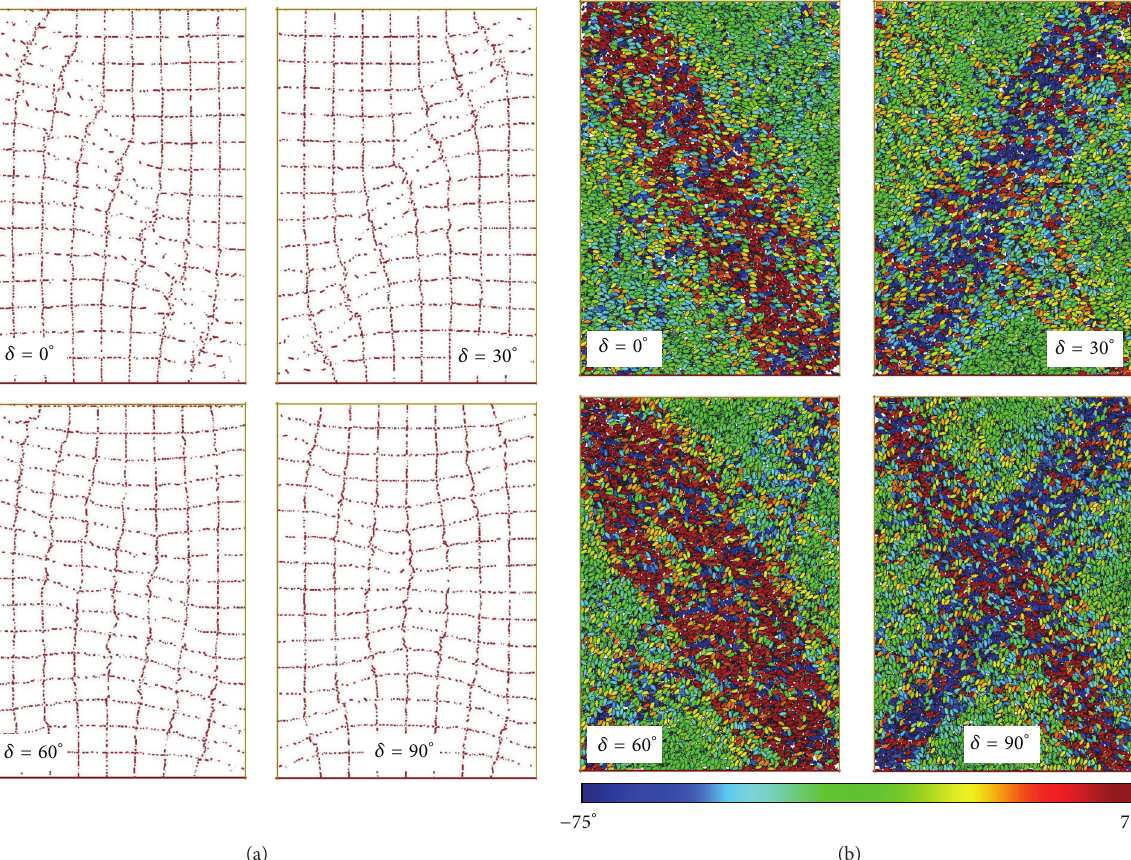
Figure 12: Deformation of biaxial compression tests at axial strain of 15% under Rigid boundary B: (a) overall deformation and (b) contours of individual particle